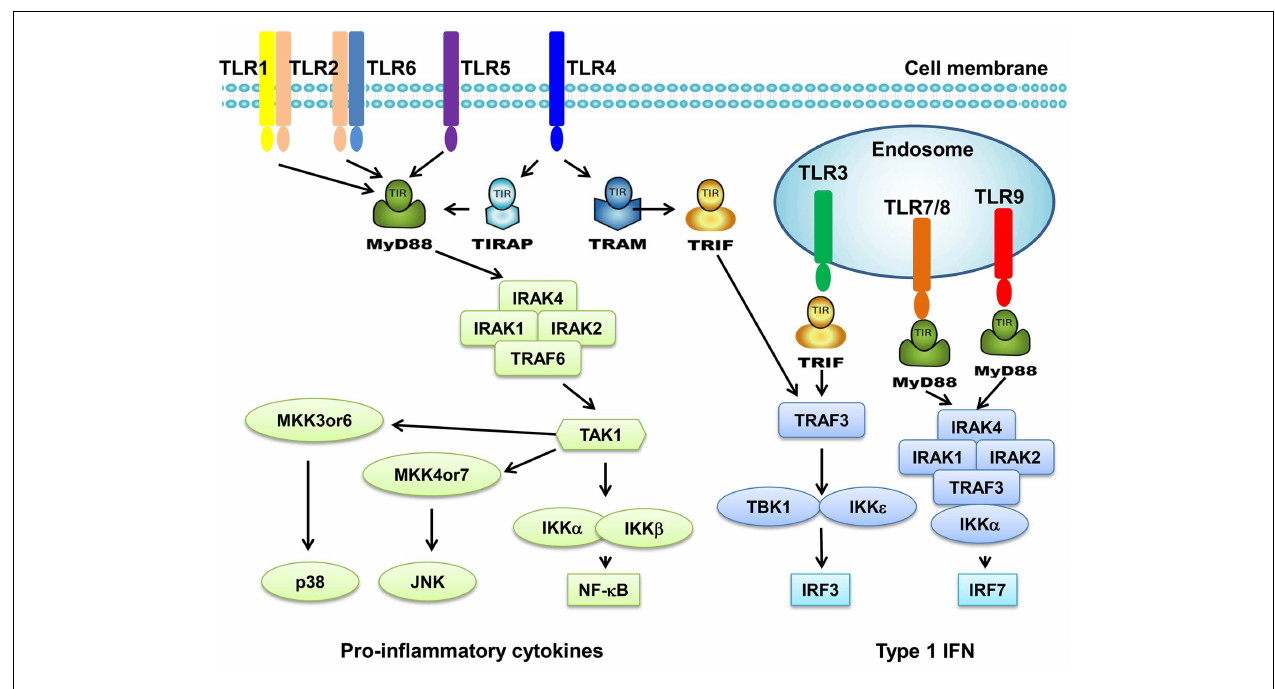
their ligands.TLR3,TLR7/8, andTLR9 are intracellularTLRs and are involved in the recognition of nucleic acids. MostTLRs, except for TLR3, signal through MyD88 pathway to activate NF- κ B and AP1.TLR3 andTLR4 can signal through MyD88-independent pathway (TRIF pathway) to activate INF- β